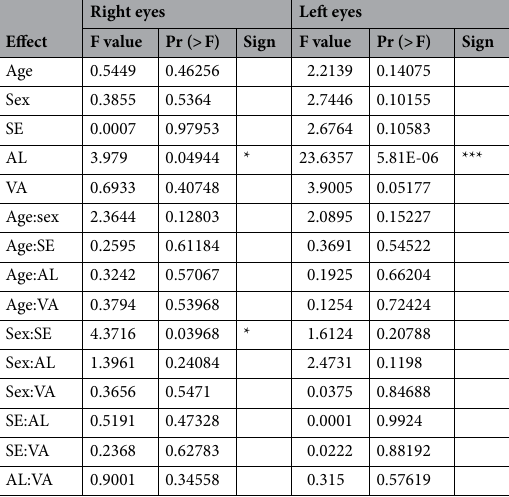
Table 2. Generalized linear model (GLM) analysis results. A GLM analysis was performed for the left and right eyes separately. The main effects of the independent variables, age, sex, spherical equivalent (SE), axial length (AL), and visual acuity (VA), and all the possible two-way interactions were taken into consideration. p-values were calculated using the F -test statistic. The “Sign” columns indicate significance codes: 0, ’***’; 0.001, ’**’; 0.01, ’*’; 0.05 ’.’; and 0.1, ’ ’